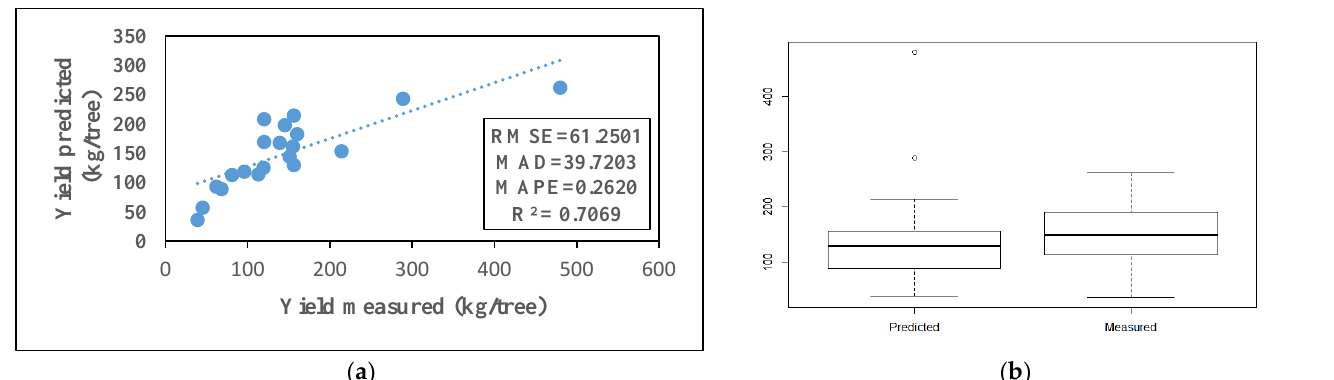
Figure 5. ( a ) Measured and predicted apple yield in testing stage of MLR; ( b ) boxplot of the meas- ured and predicted apple yield in the testing stage of MLR. Blue dots denote the observations